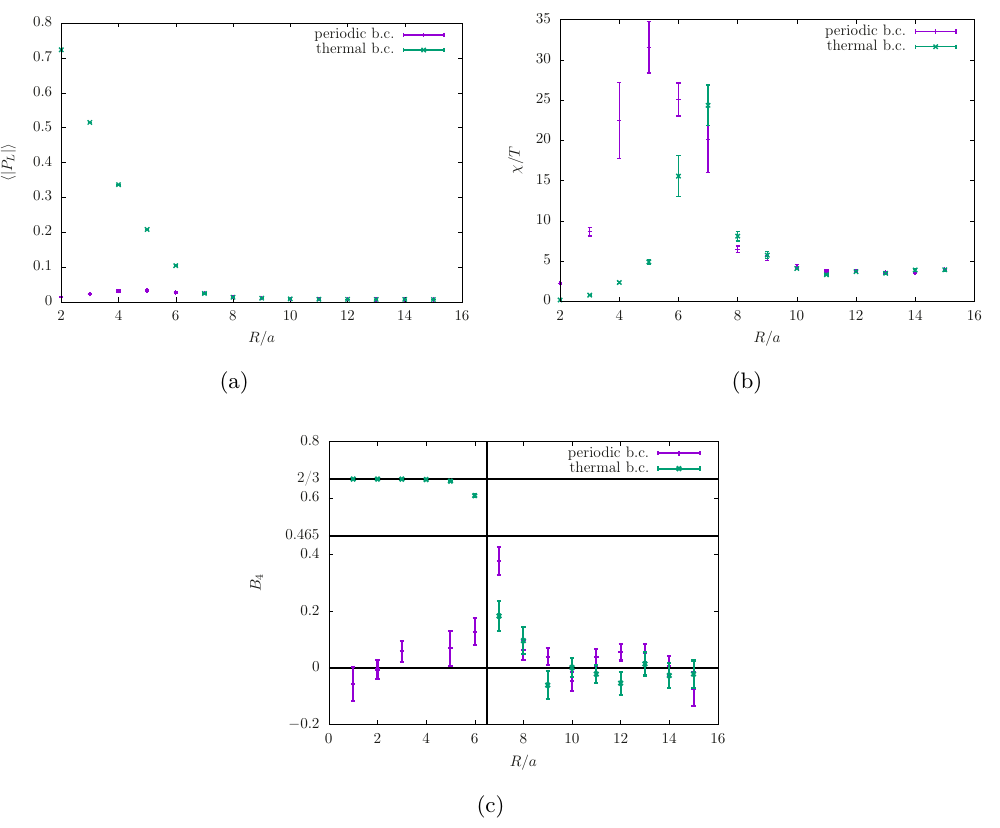
Figure 4 . The results for the Polyakov loop at β = 1 . 65, κ = 0 . 1750, c sw = 1 . 0 on a 16 3 × N t lattice as a function of N t = R/a . The plots show a comparison of periodic and thermal fermion boundary conditions: (a) the average modulus of the Polyakov loop | P L | , (b) the susceptibility of P L , and (c) the Binder cumulant. The “pion mass” (gluino-ball) at these parameters in lattice units is am π = 0 . 64631(67). The vertical line in (c) indicates the point of the deconfinement transition.